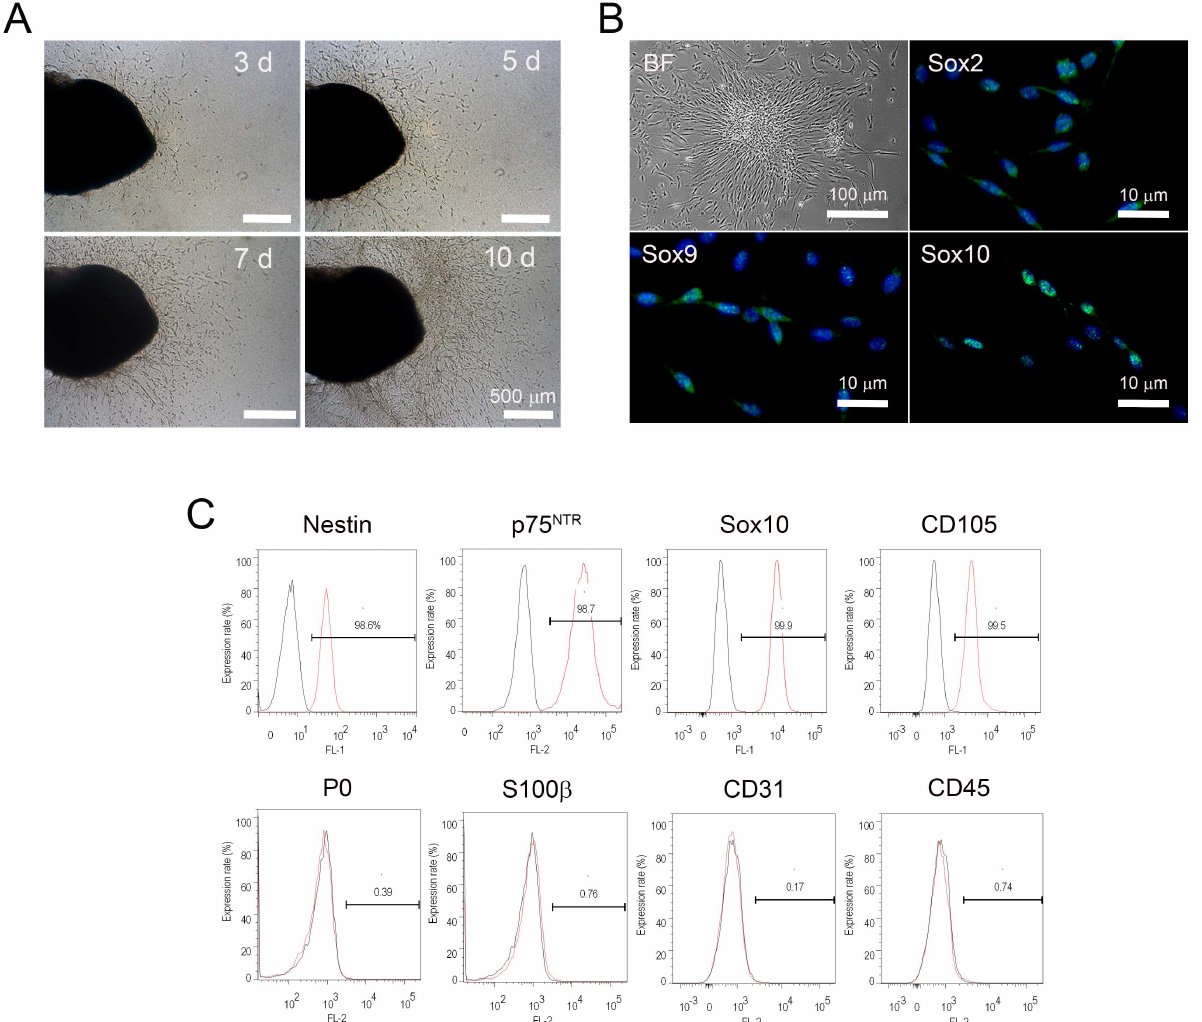
Figure 1. Isolation and immunophenotypic characteristics of peripheral nerve-derived stem cells (PNSCs). ( A ) Hydrogel- supported 3D organ culture of peripheral nerve (PN) supported cell migration/outgrowth. Cell migration/outgrowth increased in a time-dependent manner. ( B ) Migrated PNSCs in the hydrogels were isolated and then cultured under monolayer-culture conditions. PNSCs exhibited a bipolar spindle-shape appearance and expressed neural crest-specific transcription factors. ( C ) Flow cytometry assessment demonstrated that isolated PNSCs expressed markers for neural crest-lineage cells but did not express markers for myelin (P0), Schwann cells (S100 β ), or endothelial and hematopoietic cells (CD31 and CD45,